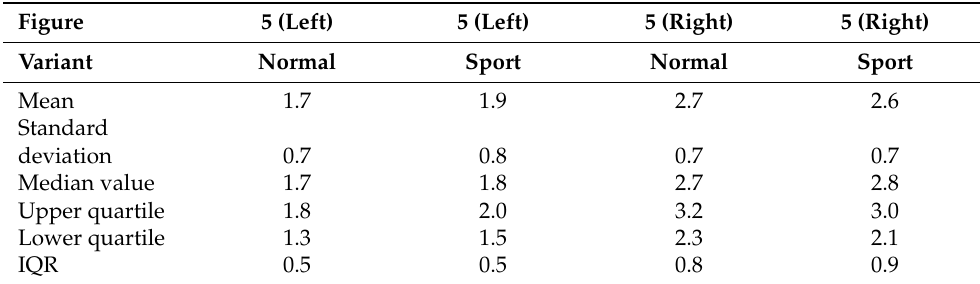
Table A2. Overview of intensity perception of audible impulses determined in this study (%). Figure